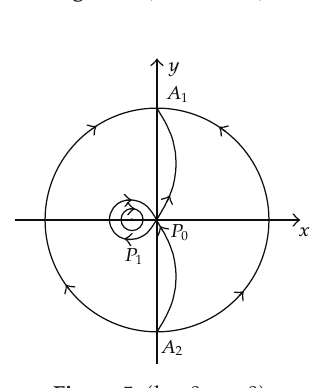
Figure 4: (cid:6) b < 0, c < 0 (cid:7) .